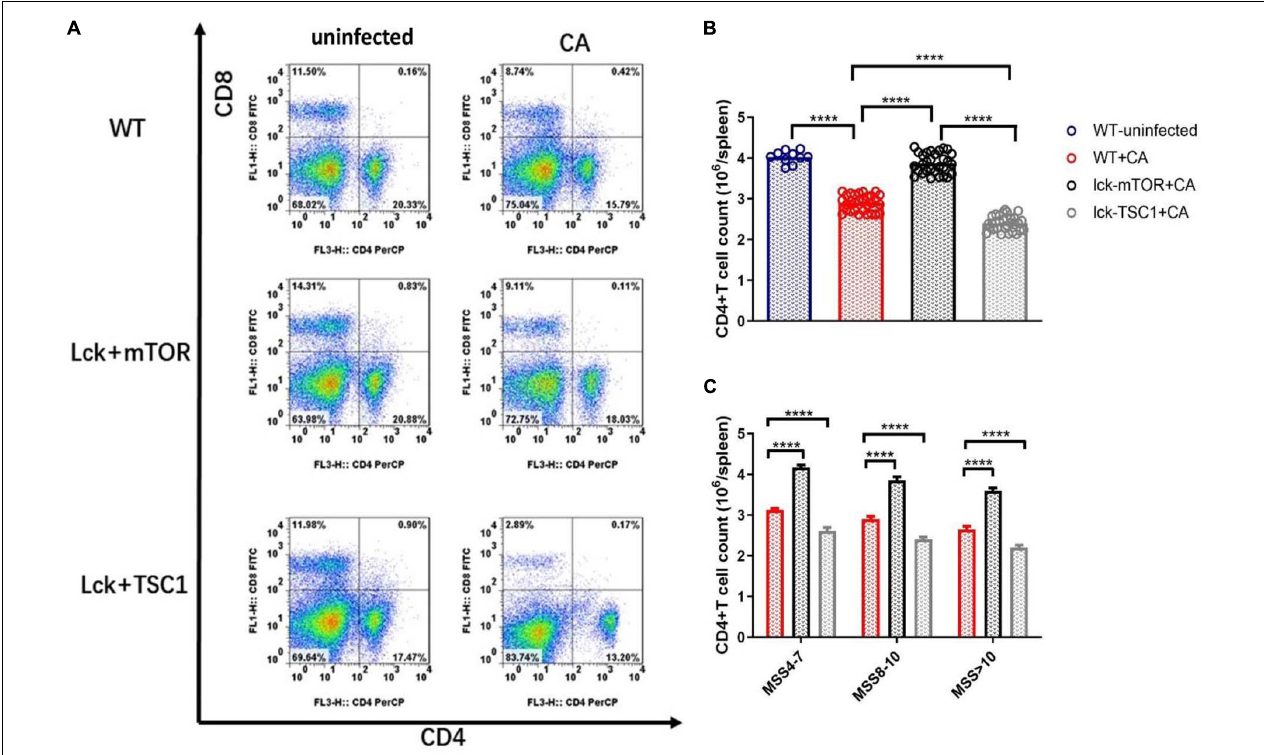
FIGURE 5 | CD4 + T cell count during Candida sepsis is affected by mTOR pathway. Splenocytes of specific gene knockout mice were obtained at 12 h after Candida injection. (A–C) Gating strategy for CD4 + CD8 − and CD4 − CD8 + T cells by flow cytometry analysis. Mean ± SD, 10 mice per MSS group (“+CA” groups contained all infected mice of three MSS groups), analyzed by one-way analysis of variance multiple comparisons. **** P <